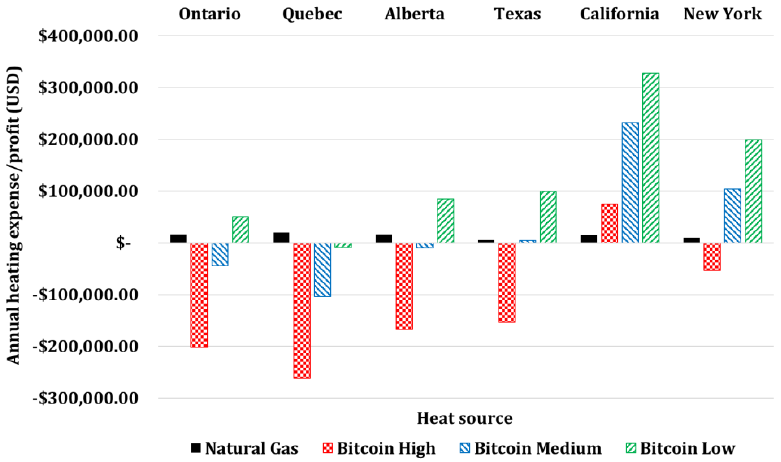
Figure 35. Annual heating expense/profit with natural gas and Bitcoin mining (after considering Bitcoin selling price) sources in six North American locations to heat Greenhouse 2.